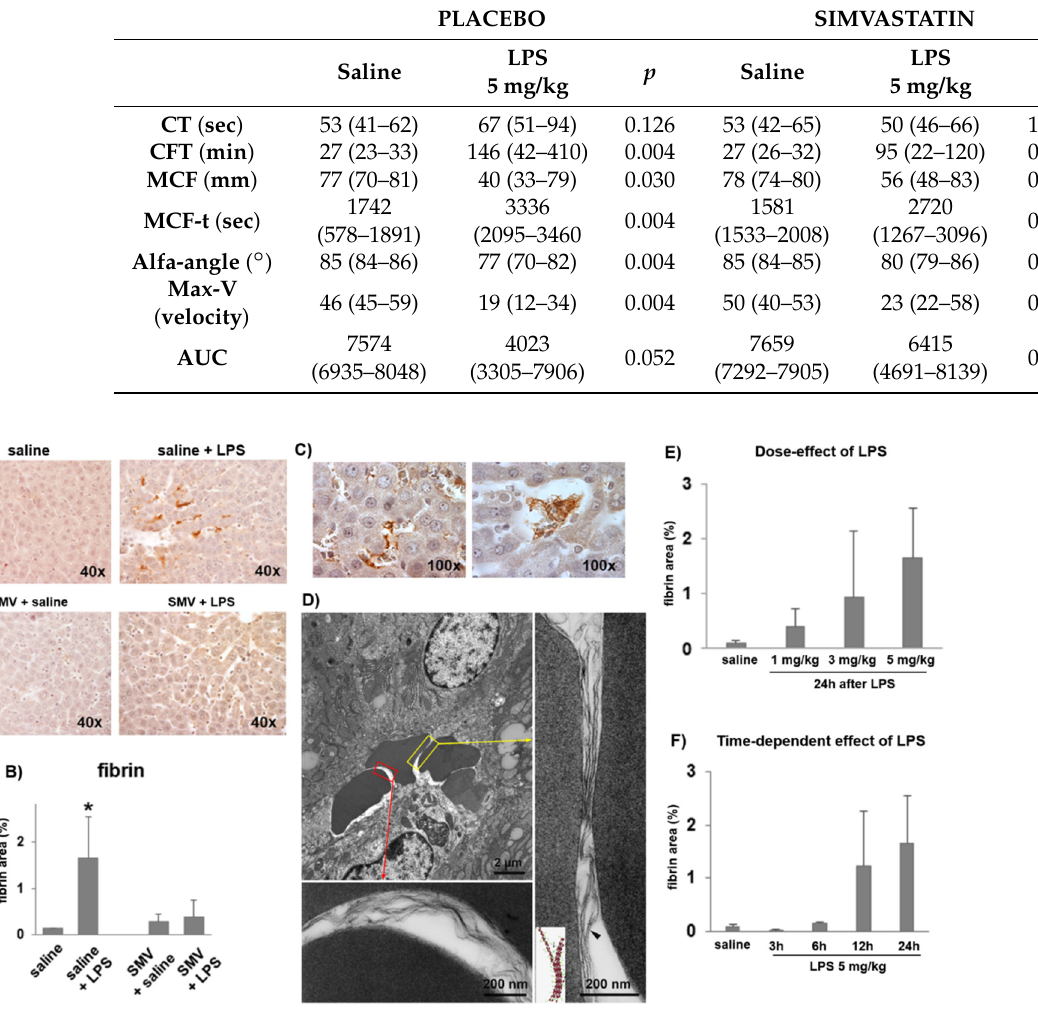
Figure 2. Fibrin deposition in the liver of rats 24 h after saline vs. LPS (5 mg/kg) in the placebo and simvastatin (SMV) group of treatment. ( A ) Fibrin was evident in liver sinusoids after LPS in the placebo treatment. ( B ) Bar-graphs showing fibrin content in liver sinusoids assessed by image analysis and expressed as %. Data are reported as mean ± SD. * p < 0.05 vs. saline. ( C ) Micrographs demonstrating fibrin deposition in a sinusoid ( left ) and in the central vein ( right ), showing that fibrin fibrils form a mesh entrapping erythrocytes. ( D ) Transmission electron micrographs of liver 24 h after LPS injection (5 mg/kg). Intrasinusoidal fibrin strands observed around some red blood cells in boxed areas are shown at higher magnification (red and yellow arrows). Arrowhead points to a fibrin strand exhibiting the typical period-based structure. The schematic representation of a fibrin strand is shown in the inset. ( E ) Bar-graphs showing fibrin deposition in rats 24 h after injection of increasing doses of LPS (1–3–5 mg/kg) or ( F ) different times after injection of LPS at 5 mg/kg (3–6 to 12–24 h). Data are reported as mean ±